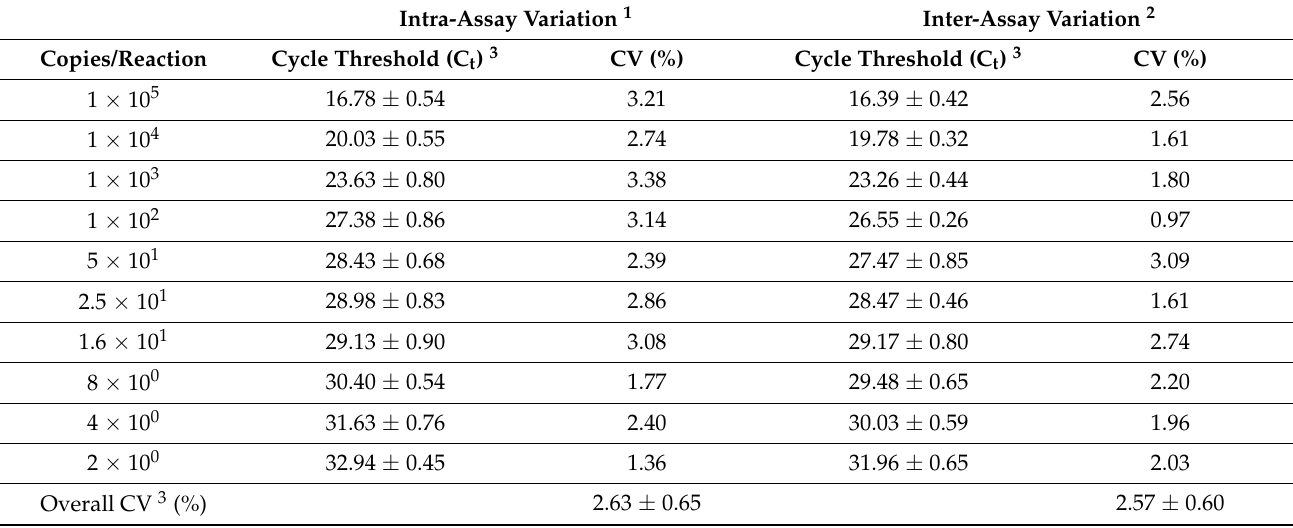
Table A2. Intra- and inter-assay variability of the real-time PCR.